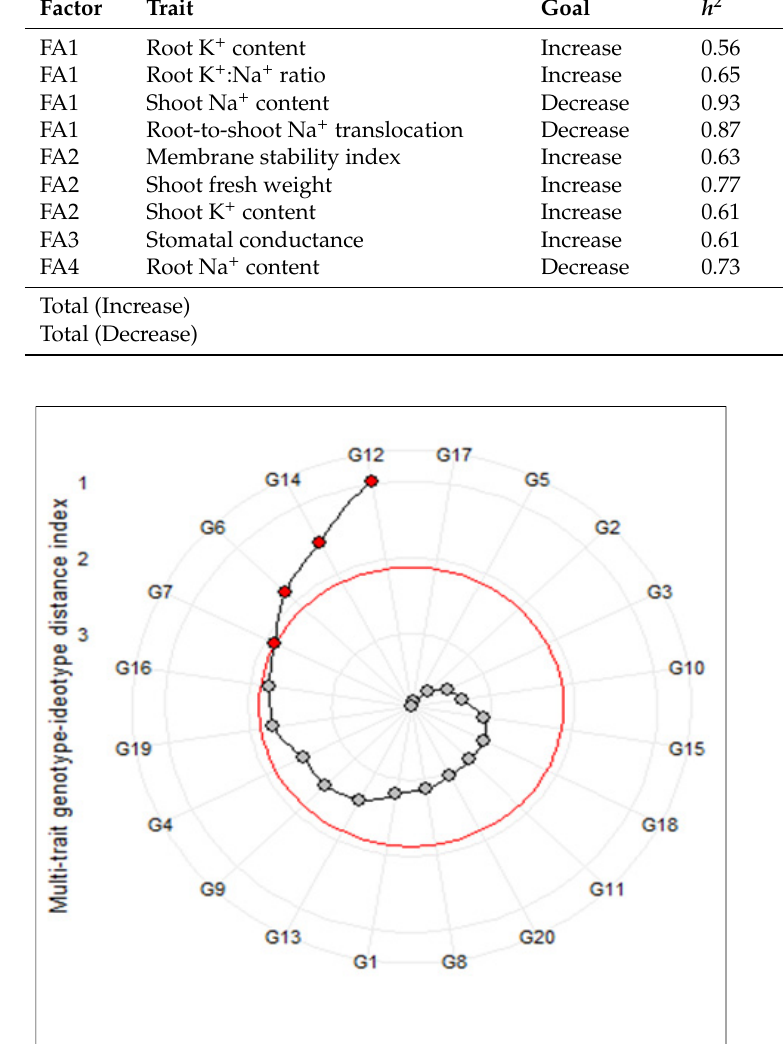
Figure 1. Genotype ranking in ascending order for the multi-trait genotype–ideotype distance (MGIDI) index. The selected genotypes based on this index are shown in red. The central red circle represents the cut-point according to the selection pressure.